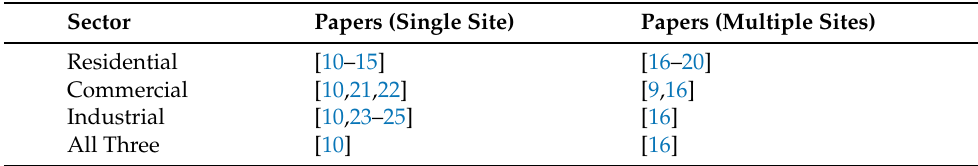
Table 1. Electric Load Sectors in Forecast